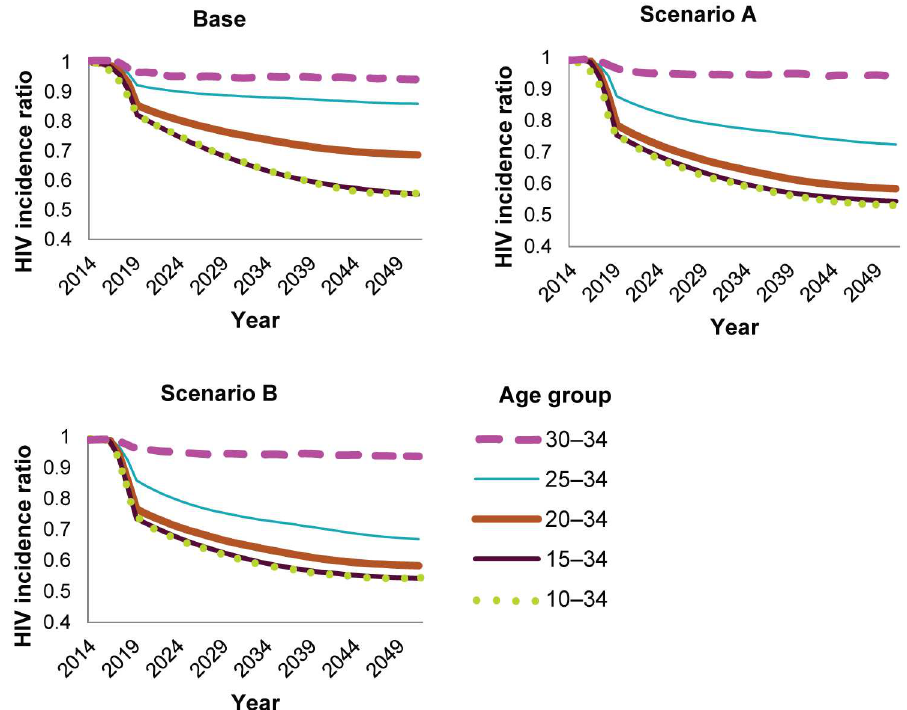
Fig 6. Impact of scaling up VMMC to progressively lower age groups in the various